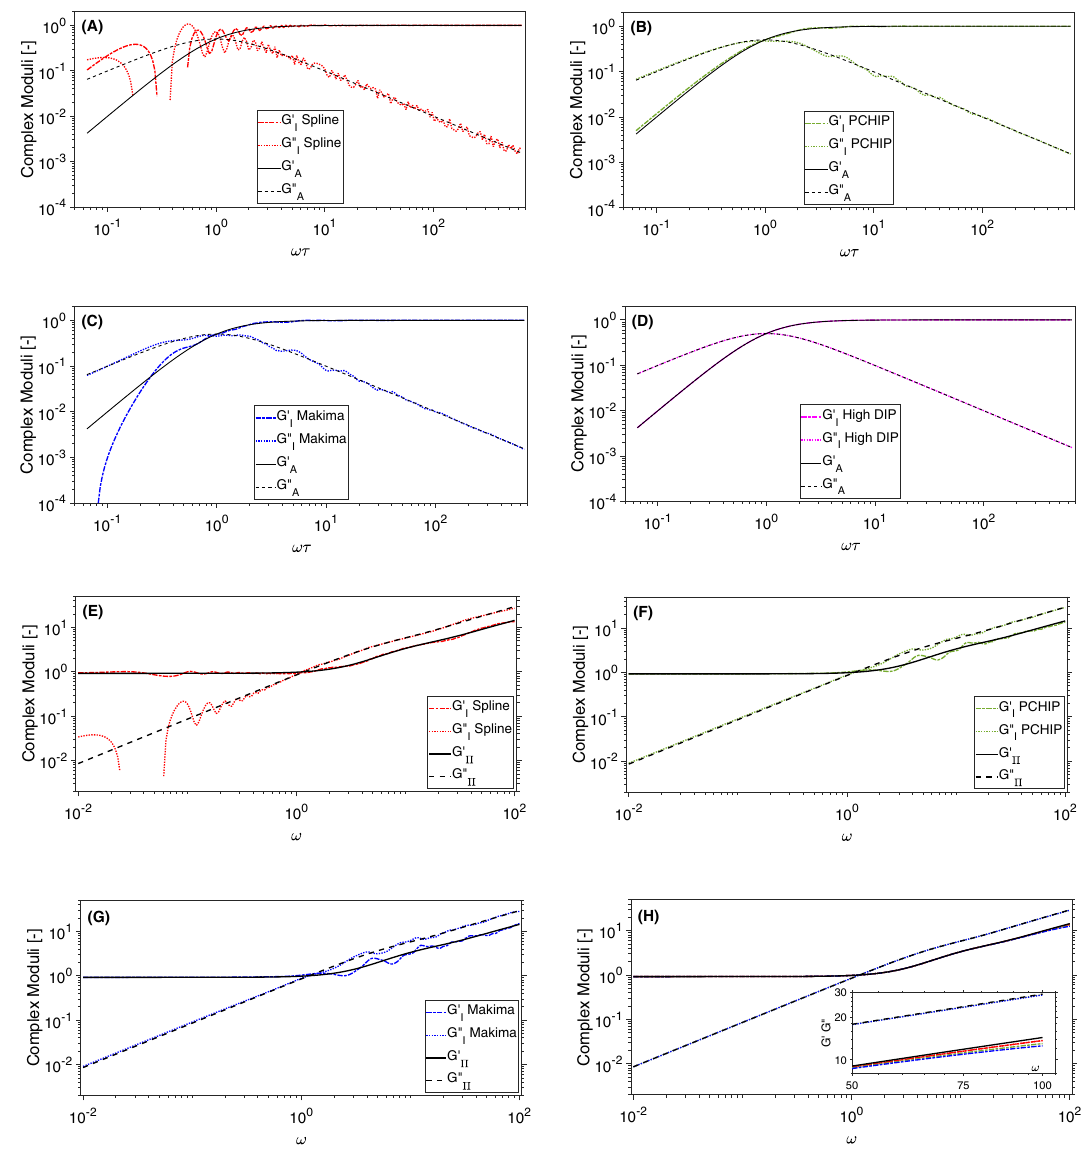
Figure 3. Comparison between the frequency-dependent complex moduli obtained via Eq. (4) and those evaluated by Fourier transforming via Eq. (1) the interpolations functions shown in Fig. 1 for DIP = 1 / 4 in ( A , B , C , E , F , G ) and for DIP = 1 in ( D , H